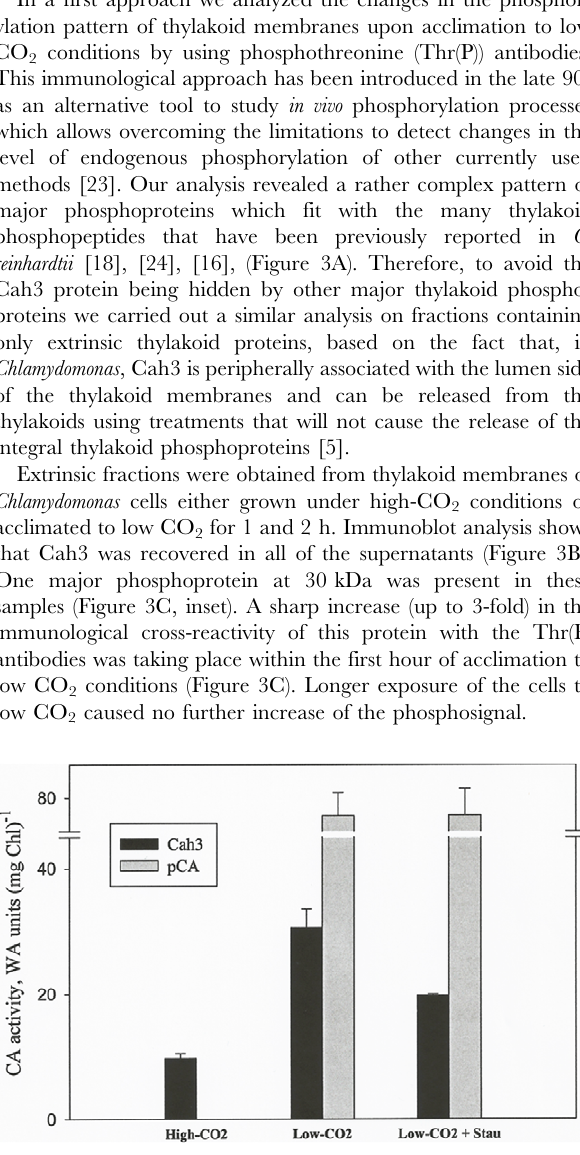
Figure 2. Staurosporine, a protein kinase inhibitor, partially inhibits the activation of Cah3 activity. High-CO 2 -grown C. reinhardtii cells were acclimated to low CO 2 conditions for 2 h in the absence or in the presence of 0.1 m M Staurosporine. CA activity was measured in thylakoid membranes isolated from control and treated cells. As a control, periplasmic CA activity was measured using intact cells of the same cultures. Values are means 6 SE ( n =5).